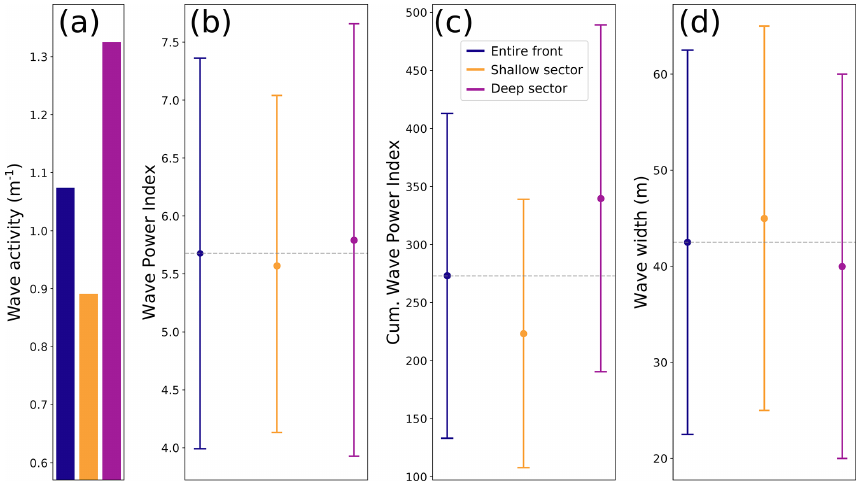
Figure 6. (a) Wave activity, (b) temporally averaged WPI, (c) temporally cumulated WPI along the calving front, and (d) wave width at the generation point. The wave activity is obtained by normalizing the number of detected waves by the sector width. For panels (b) – (d) , sector-averaged values are shown as dots and the associated standard deviations for each sector as bars ( ± 1 σ ). Gray horizontal lines indicate mean values along the entire